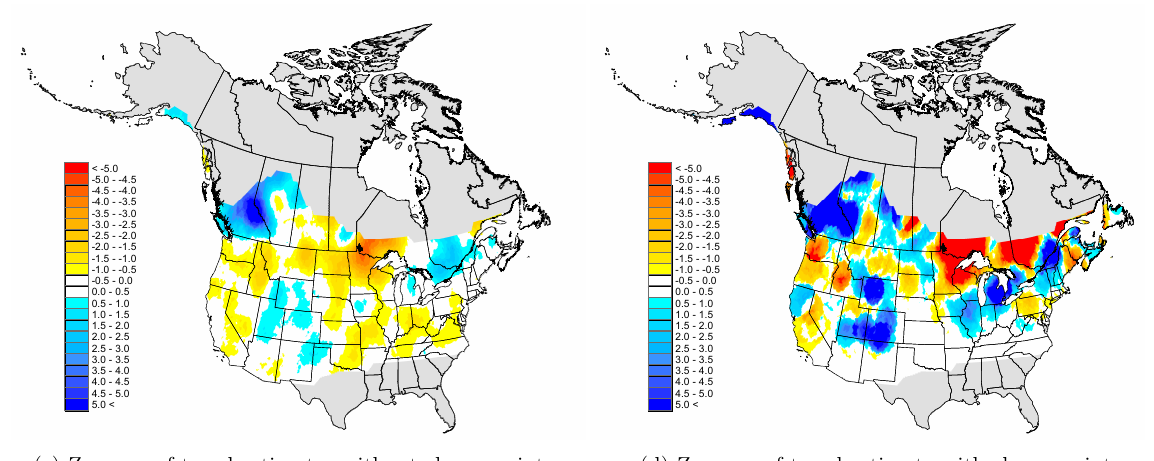
Figure 1. Top left graph: North American snow trends when changepoints are neglected. Top right graph: North American snow trends when changepoints are taken into account. Bottom left graph: z scores for no trend when changepoints are neglected. Bottom right graph: z -scores for no trend when changepoints are taken into